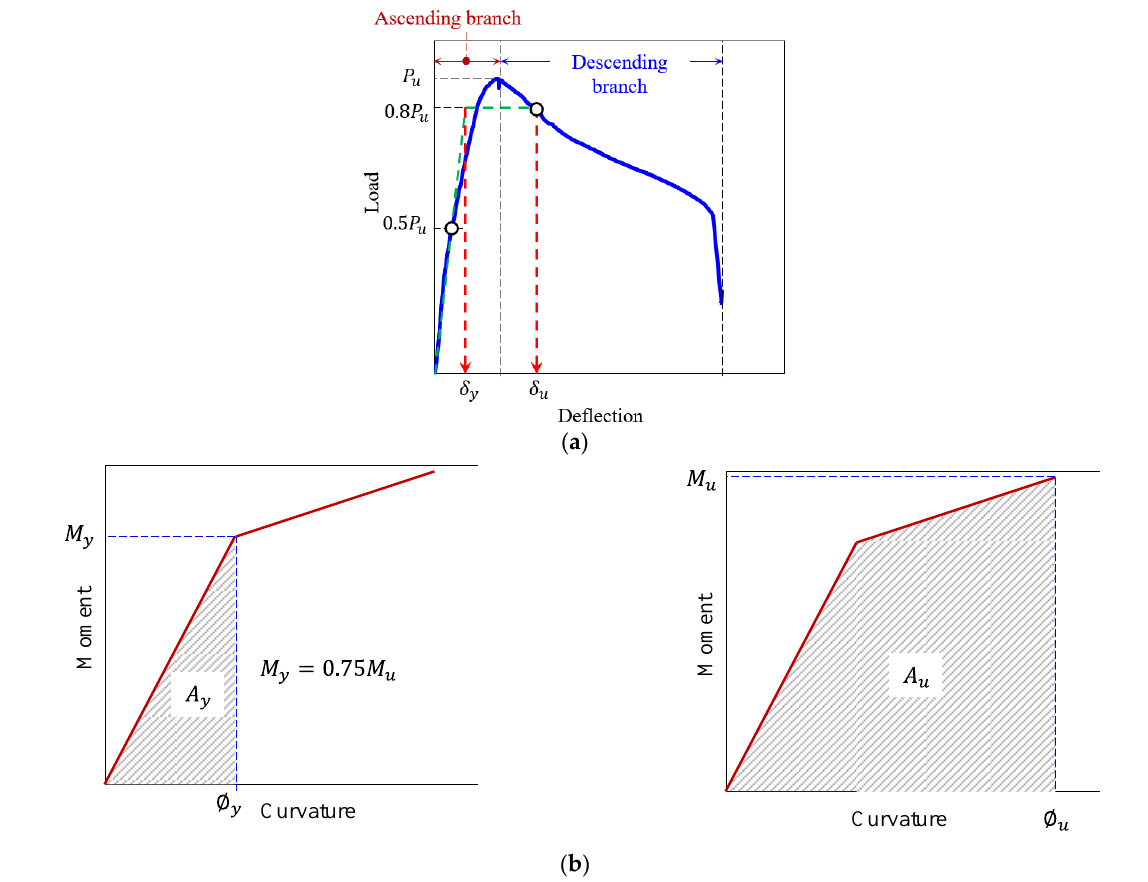
Figure 11. Ductility calculated by ( a ) deflection ( 𝜇 𝐷 ) and ( b ) moment – curvature area ( 𝜇 ). Table 6. Ductility analysis of the reinforced UHPC